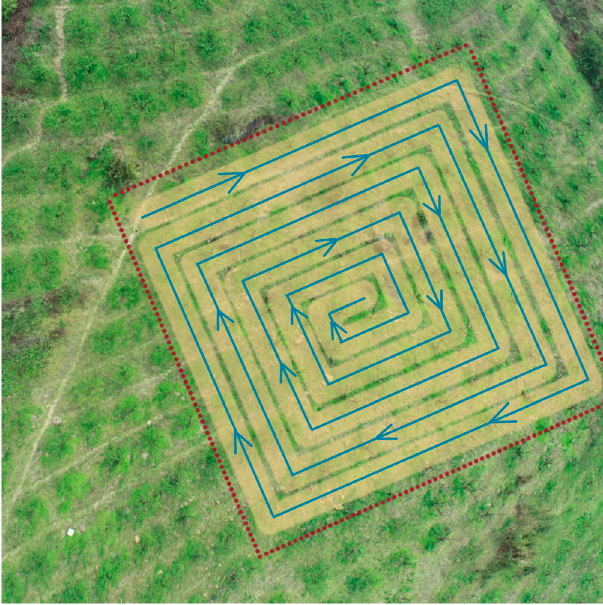
Figure 5. Internal Spiral